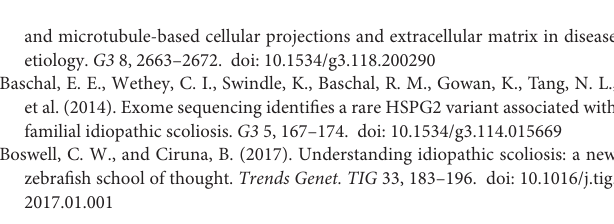
Supplementary Table 7 | The oligo sequences for all the injections. Supplementary Table 8 | The zebrafish counting of post injection for each